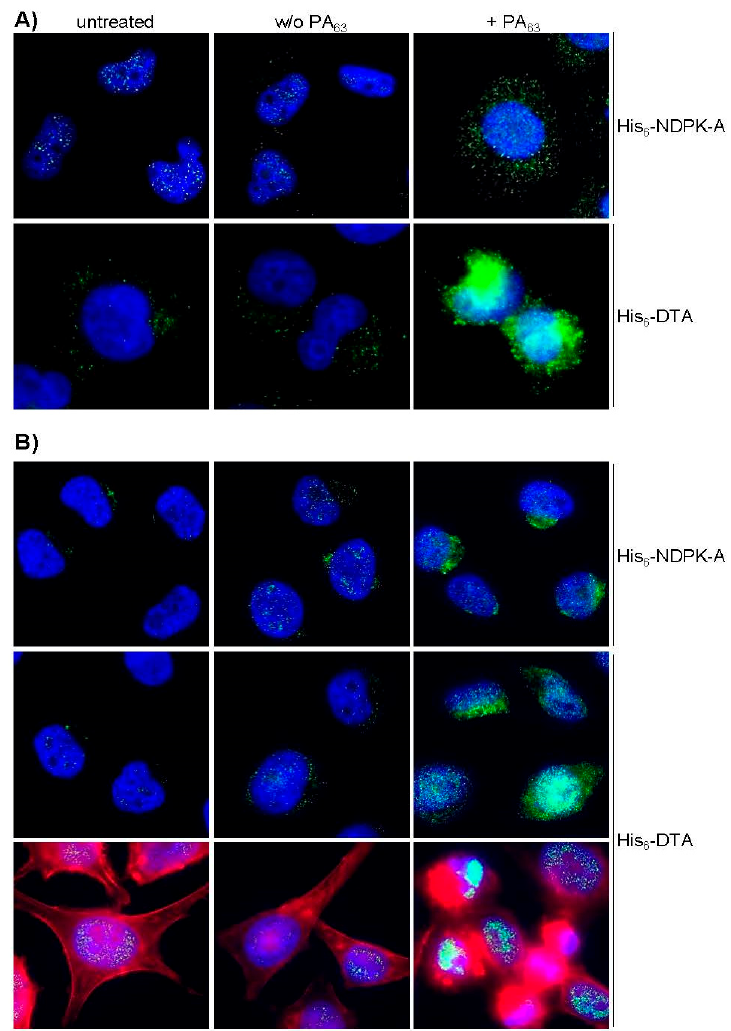
Figure 4. PA 63 mediates the delivery of His 6 -NDPK-A and His 6 -DTA into MDA-MB-231 and HeLa cells. ( A ) MDA-MB-231 cells were incubated for 48 h at 37 ◦ C with either His 6 -NDPK-A (10 µ g / mL) or cells. ( A ) MDA-MB-231 cells were incubated for 48 h at 37 °C with either His 6 -NDPK-A (10 µg/mL) or His 6 -DTA (5 µ g / mL) in the presence or absence of PA 63 (1 µ g / mL). ( B ) HeLa cells were treated the His 6 -DTA (5 µg/mL) in the presence or absence of PA 63 (1 µg/mL). ( B ) HeLa cells were treated the same way for 3 h. His-tagged proteins (green) were visualized by fluorescence microscopy. After incubation with an anti-His-antibody, immunostaining was performed with a goat anti-mouse-Alexa Fluor568 antibody. Nuclei were stained with Hoechst 333342 (blue); F-actin cytoskeleton was stained with Phalloidin-FITC (red) to visualize the His 6 -DTA-induced cell-rounding. Representative cells are shown.